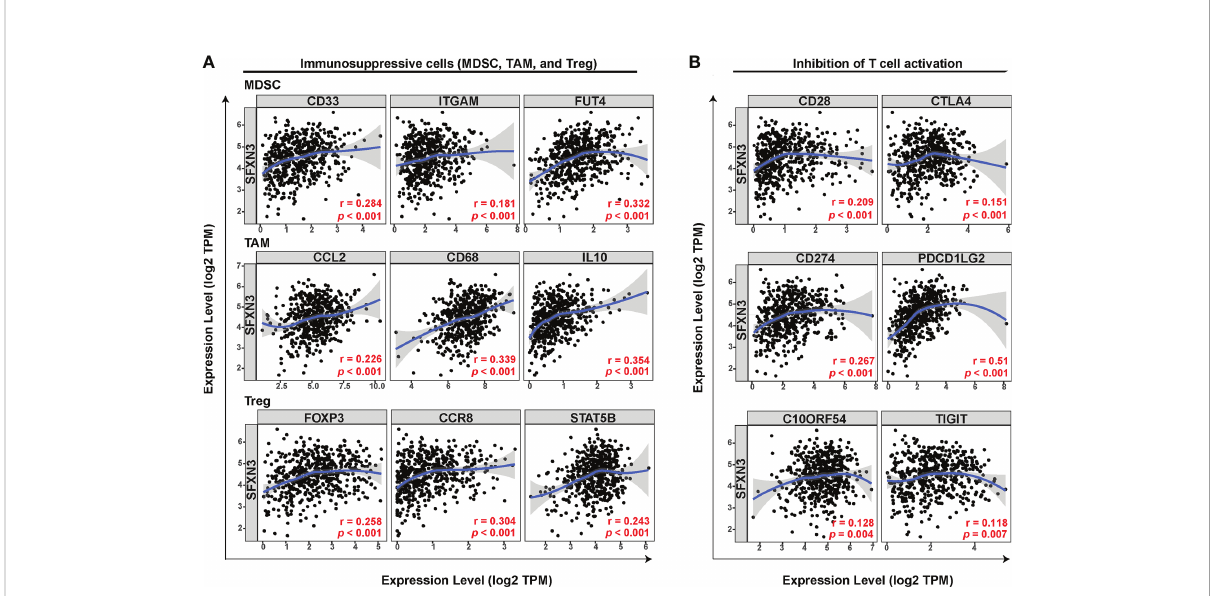
FIGURE 3 SFXN3 expression correlates signi fi cantly with markers of immunosuppressive molecules and cells. (A) Correlation between SFXN3 expression and markers of immunosuppressive cells (MDSCs, TAMs, and Tregs). (B) Correlation between SFXN3 expression with molecules involved in inhibition of T-cell activation ( CD28 , CTLA4 , CD274 , PDCD1LG2 , VSI R, and TIGIT